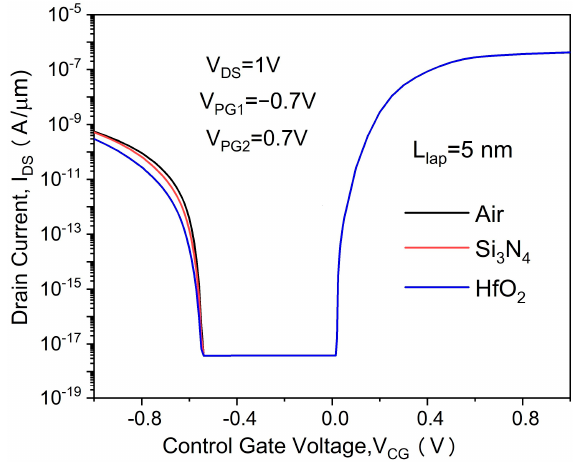
Figure 6. Energy band diagrams at ( a ) 1 nm and ( b ) 5 nm below the Si–oxide interface of the pro- posed ED-TFET with an ED drain at OFF state.